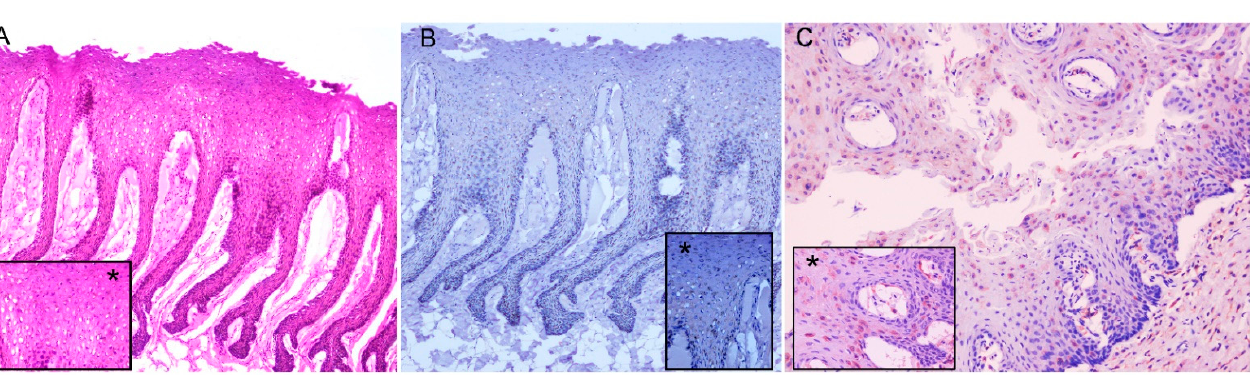
Figure 4. Histological and Immunohistochemistry evaluation of PCR-positive skin sample from a Cuvier’s Beaked whale (CET 182). ( A ) Histopathology. Most of the keratinocytes of the stratum spinosum exhibit ballooning (freeze artefact). HE stain, ×10. Inset: Detail of the ballooning (*). HE stain, ×40. ( B ) Immunohistochemistry. CDV immunostaining was not observed. Immunohistochemistry stain, X 10. Inset: detail of lack of specific immunostaining against CDV in keratinocytes (*). Immunohistochemistry stain, ×40. ( C ) Immunohistochemistry. Positive control for CDV antibody in laryngeal tonsil sample. Immunostaining was observed in the cytoplasm of epithelial cells. Immunohistochemistry for morbillivirus using an antibody to CDV nucleoprotein., ×20. Inset: detail of specific immunostaining against CDV in epithelial cells (*).